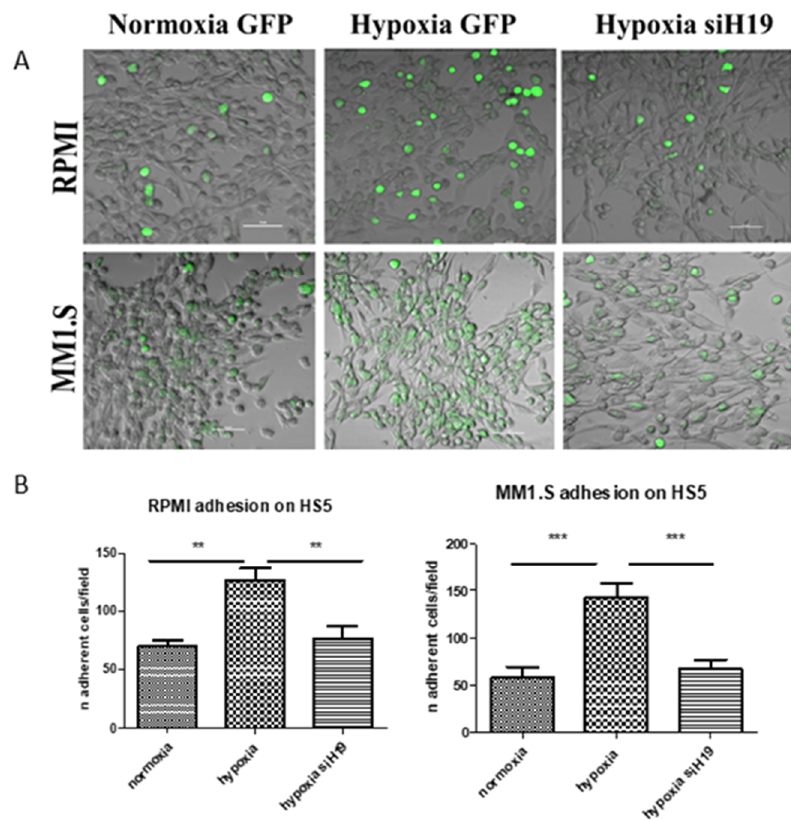
Figure 3. Adhesion assay of MM cells to stromal monolayer, in normoxia and after hypoxic stimulation, silenced or not for lncH19. Representative images of different experimental condition captured by Nikon A1 confocal microscope, scale bar = 50 µ m ( A ); quantification of Green Fluorescent Protein (GFP) positive MM adherent cells. Values are presented as mean ± SD. Statistical analysis was performed by the use of one way ANOVA test and Dunnett’s multiple comparison test ** p < 0.001; *** p < 0.0001 ( B ).